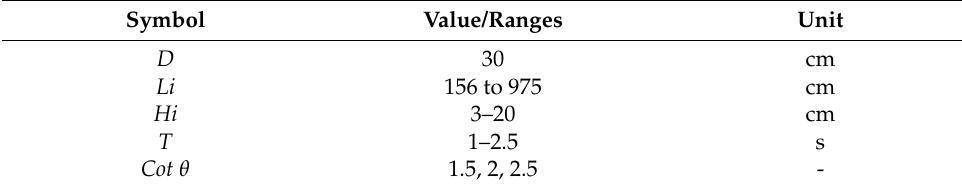
Table 1. The governing parameters and their range/values used for the experiments.